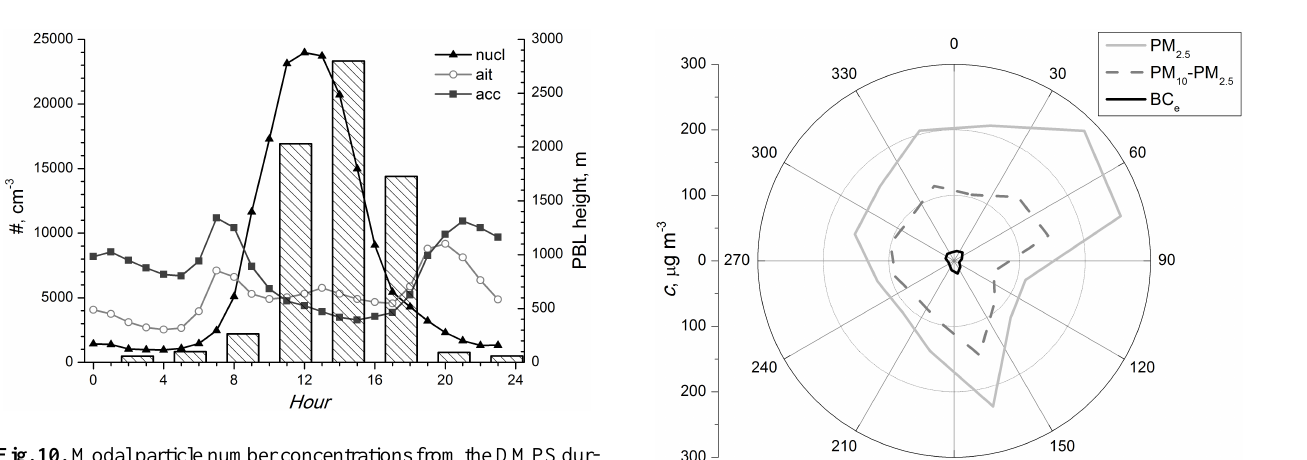
Fig. 10. Modal particle number concentrations from the DMPS dur- ing the pre-monsoon period. Also the pre-monsoon boundary layer height (PBL) is shown.